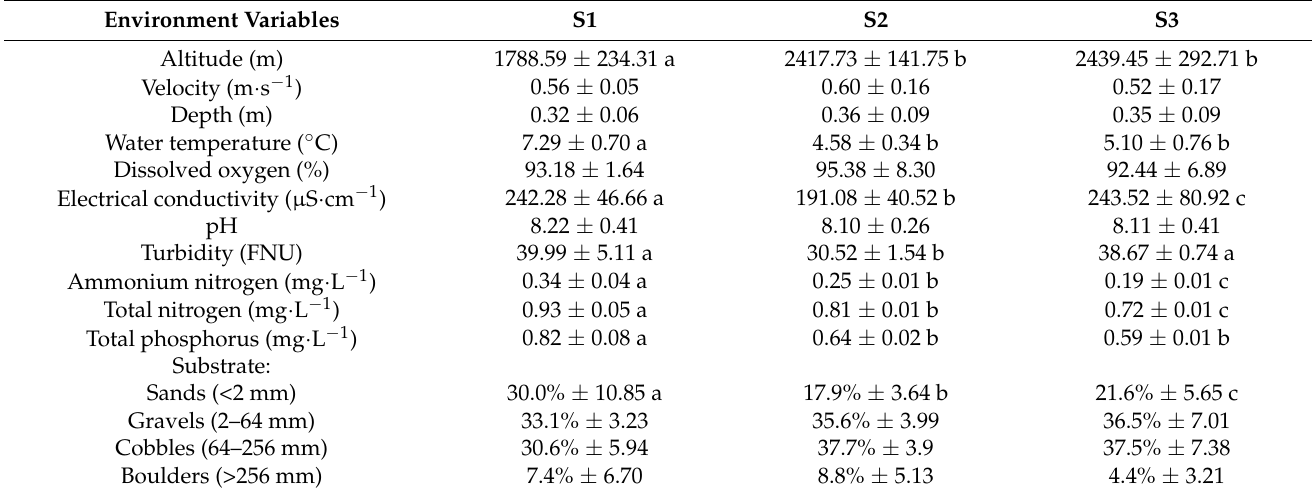
Table 2. A summary of the differences in altitude (m), velocity (m · s − 1 ), depth (m), water